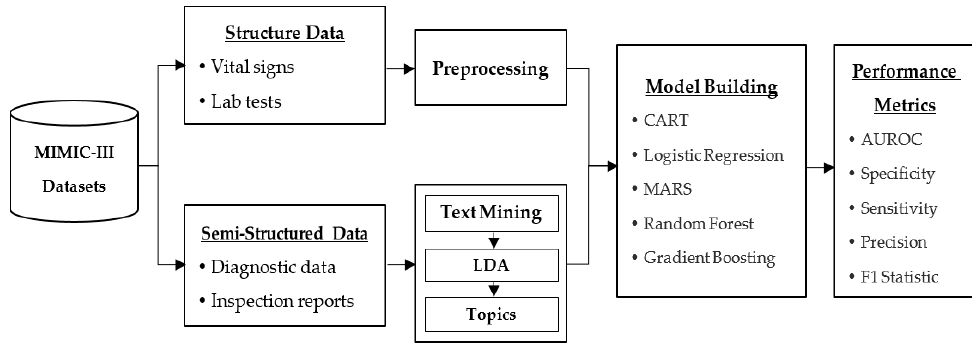
Figure 1. Research scheme.